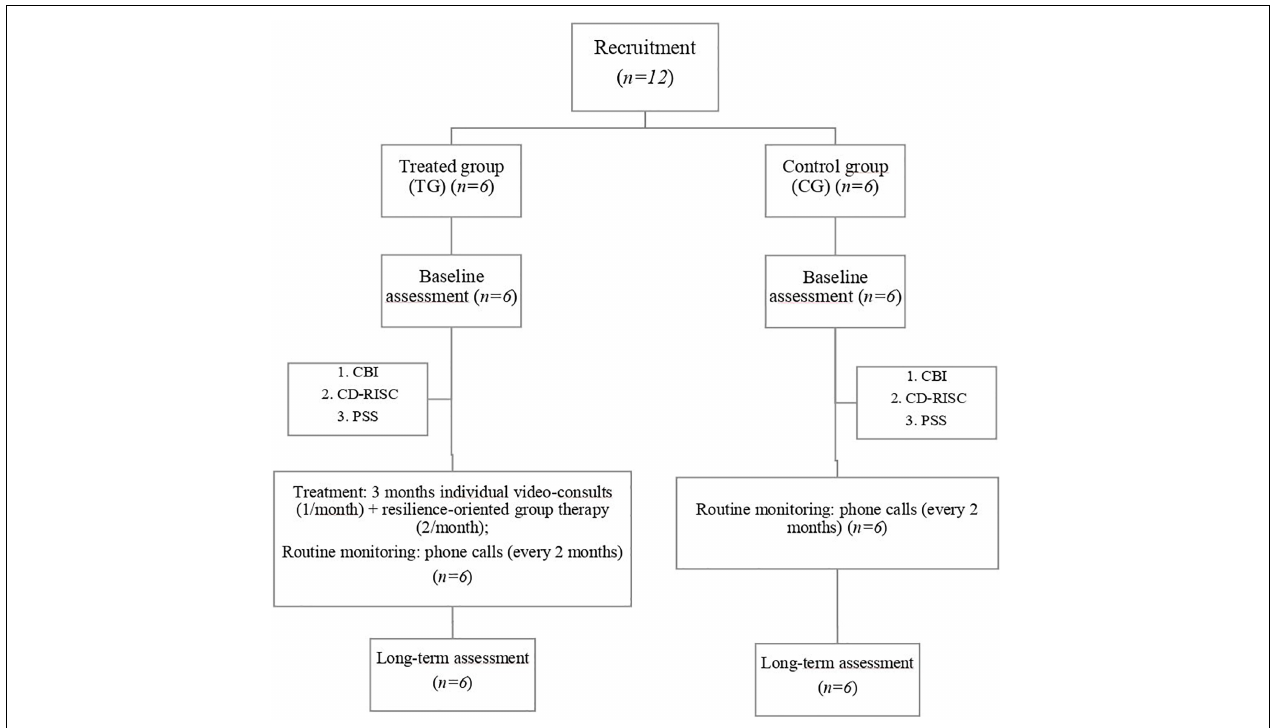
FIGURE 1 | A flowchart of the recruited and monitored